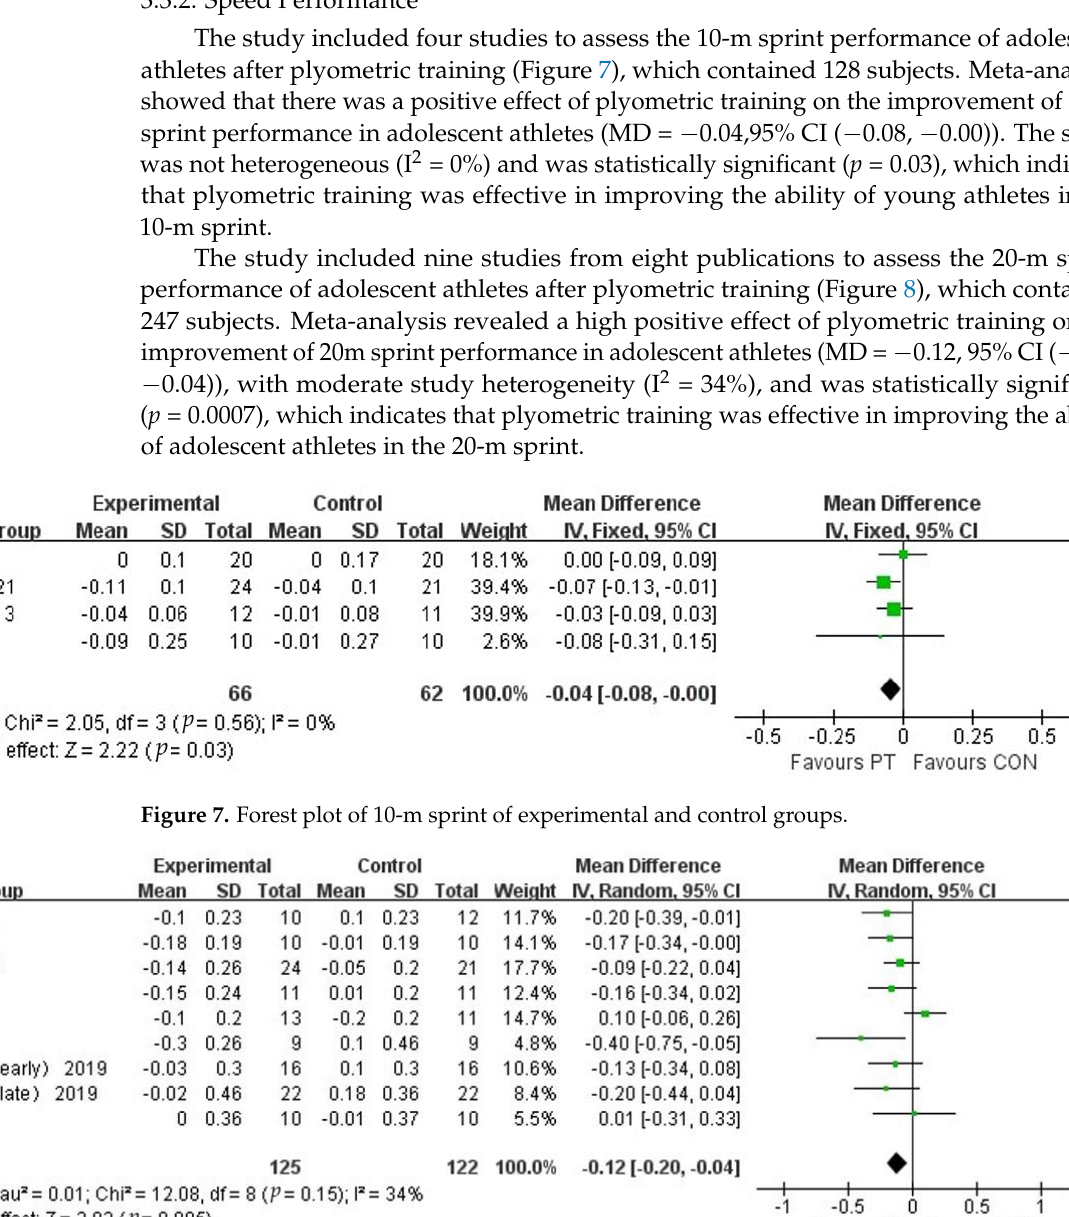
Figure 6. Forest plot of SLJ of experimental and control groups.